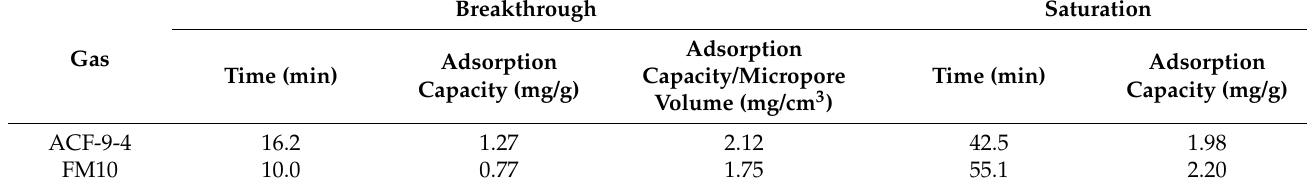
Table 5. Breakthrough and saturation adsorption capacity of the LLDPE-based activated carbon fibers.